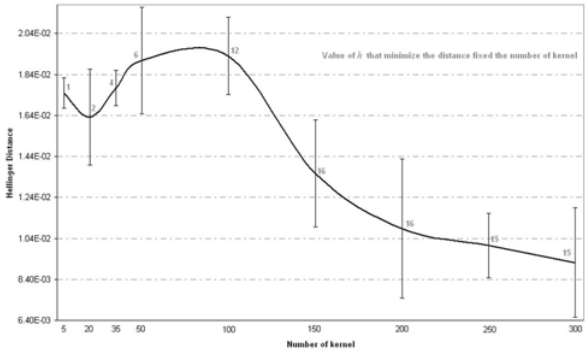
Fig. 5. Mean and standard deviation of the distance between the true PDF and its vector quantization based Parzen estimation with varying number of kernels and optimized value of the width scaling factor h